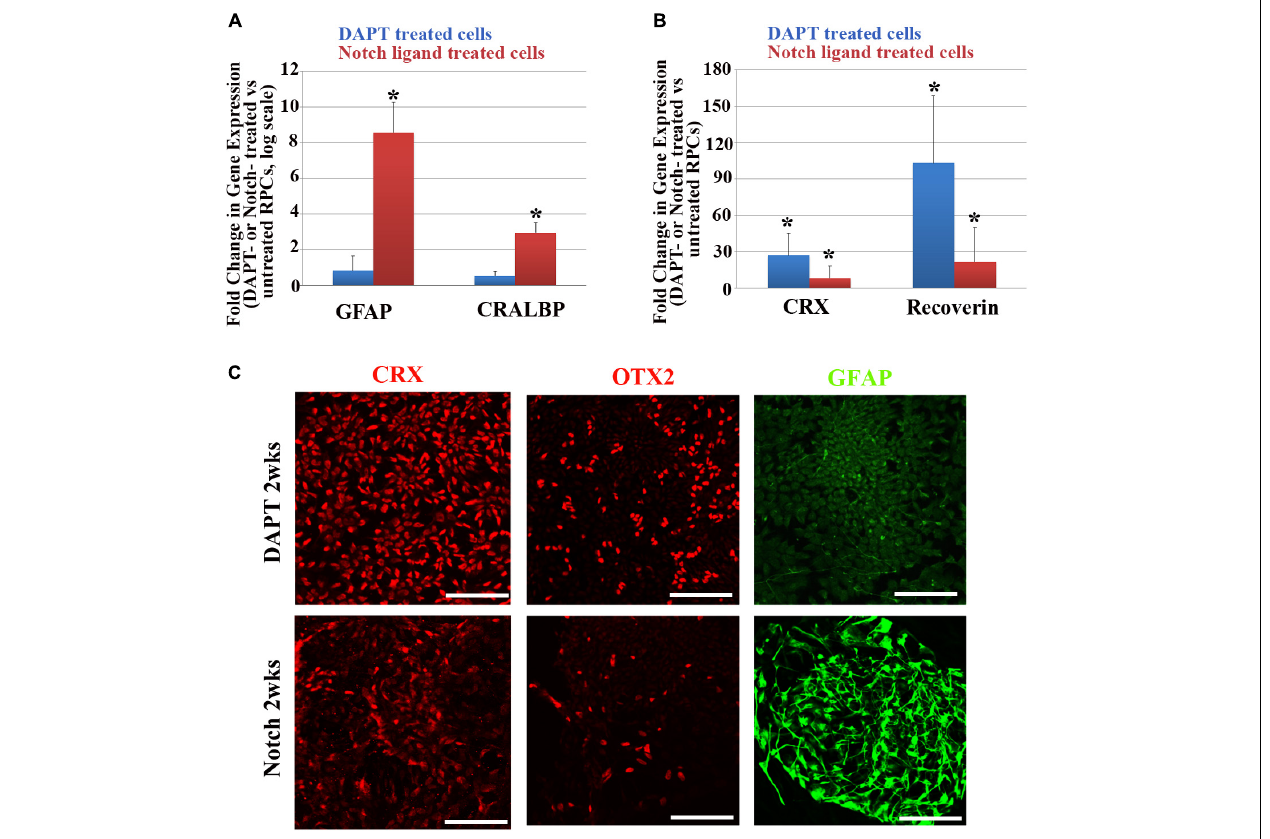
FIGURE 3 | Changes in glial cell- and retinal neuron-associated markers after Notch promotion or inhibition in RPCs. (A,B) qRT-PCR analyses of changes in glial cell-associated markers including GFAP and CRALBP (A) and retinal neuron-associated markers including CRX and recoverin (B) in RPCs 2 weeks after treatment with Notch ligands or Notch inhibitor DAPT. ∗ p < 0.05, RPCs treated with Notch ligands or Notch inhibitor DAPT vs. untreated RPCs, n = 3–4/group. (C) Immunostaining showing that most RPCs treated with the Notch inhibitor DAPT for 2 weeks were positive for the neuronal markers CRX and OTX2 but they expressed little of the glial cell marker GFAP (upper panel) . In contrast, 2 weeks after Notch ligand treatment only a few cells were positive for CRX and OTX2 and the majority of cells became positive for the glial cell marker GFAP (lower panel) . Scale bar: 100 µ m. Error bars represent